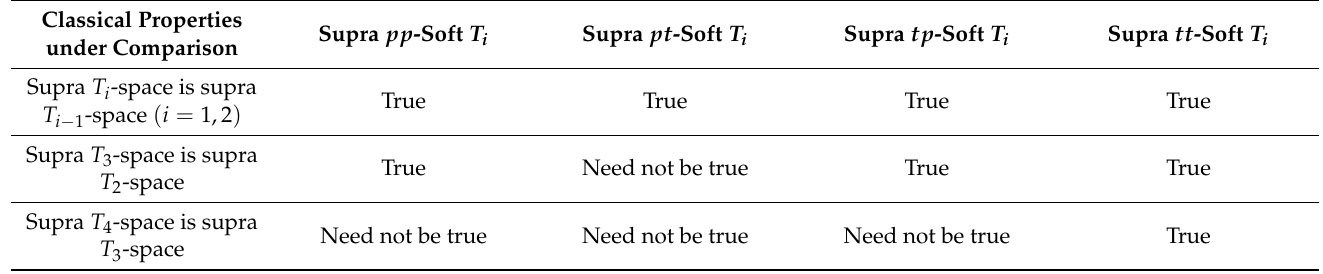
Table 2. Description of some properties via classical supra topology and supra-soft